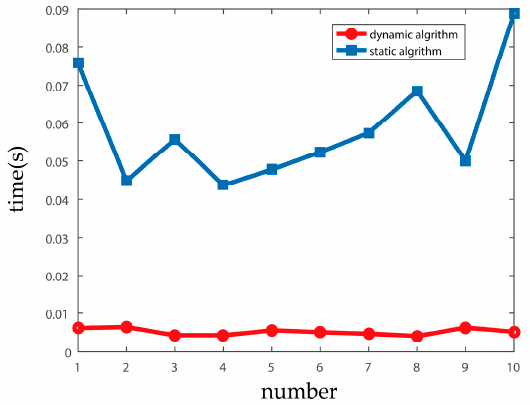
Figure 10. Running time of both algorithms.